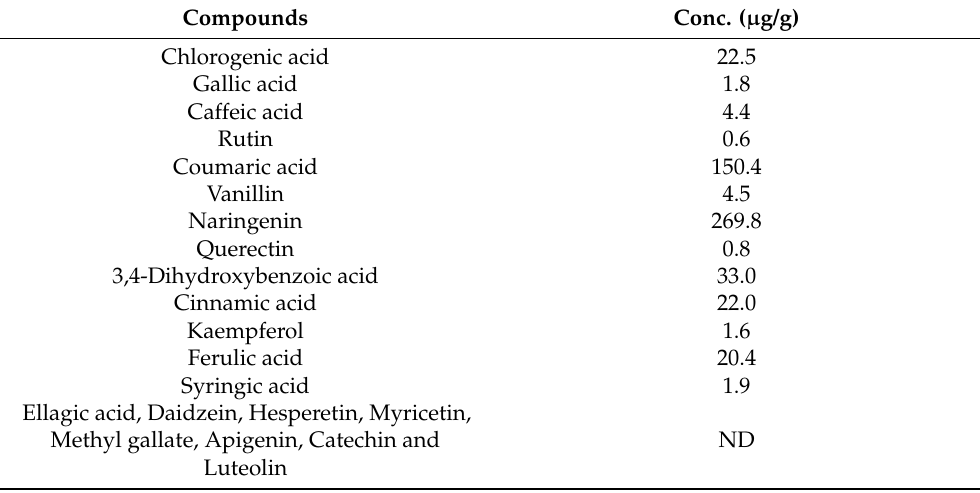
Table 2. Polyphenolic compounds identified in the methanol extract of Moringa oleifera leaves. Compounds Conc. ( µ g/g) Chlorogenic